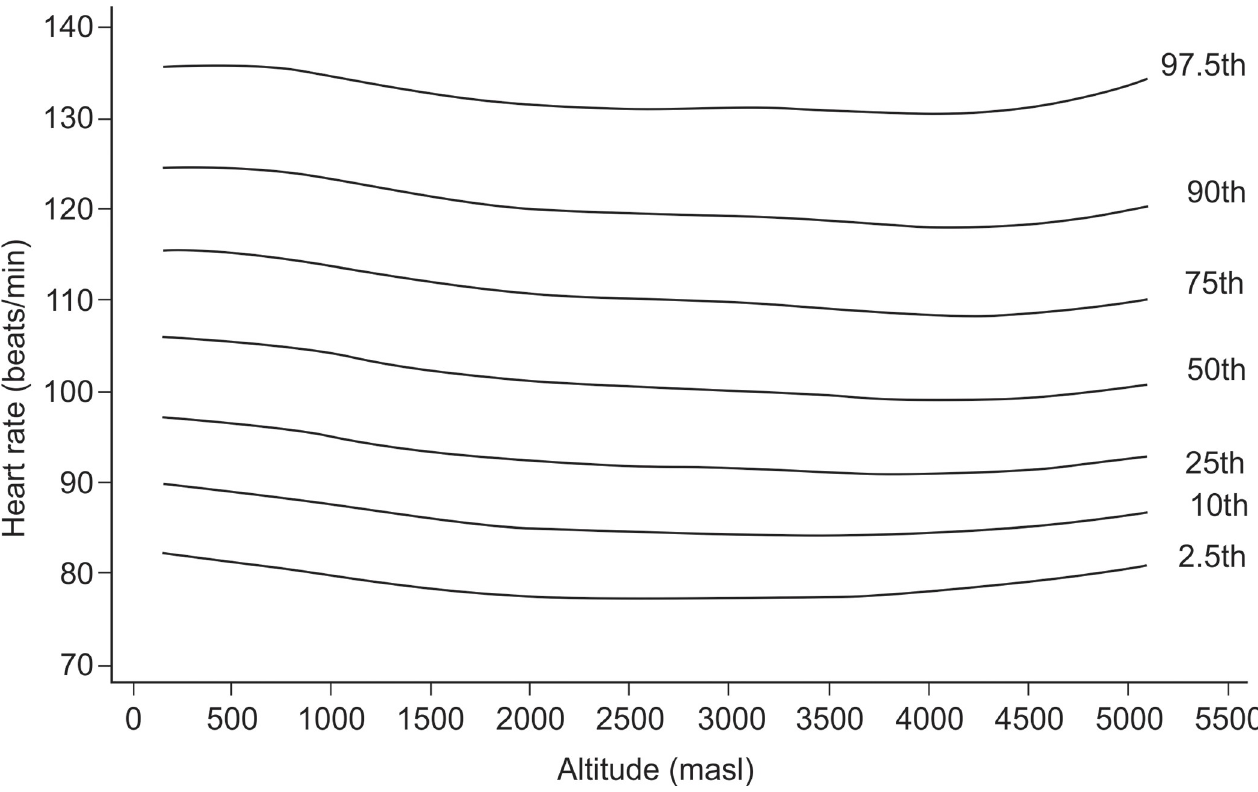
Fig 2. Heart rate at rest according to altitude of residence in Peruvian children of 6–17 years of age.